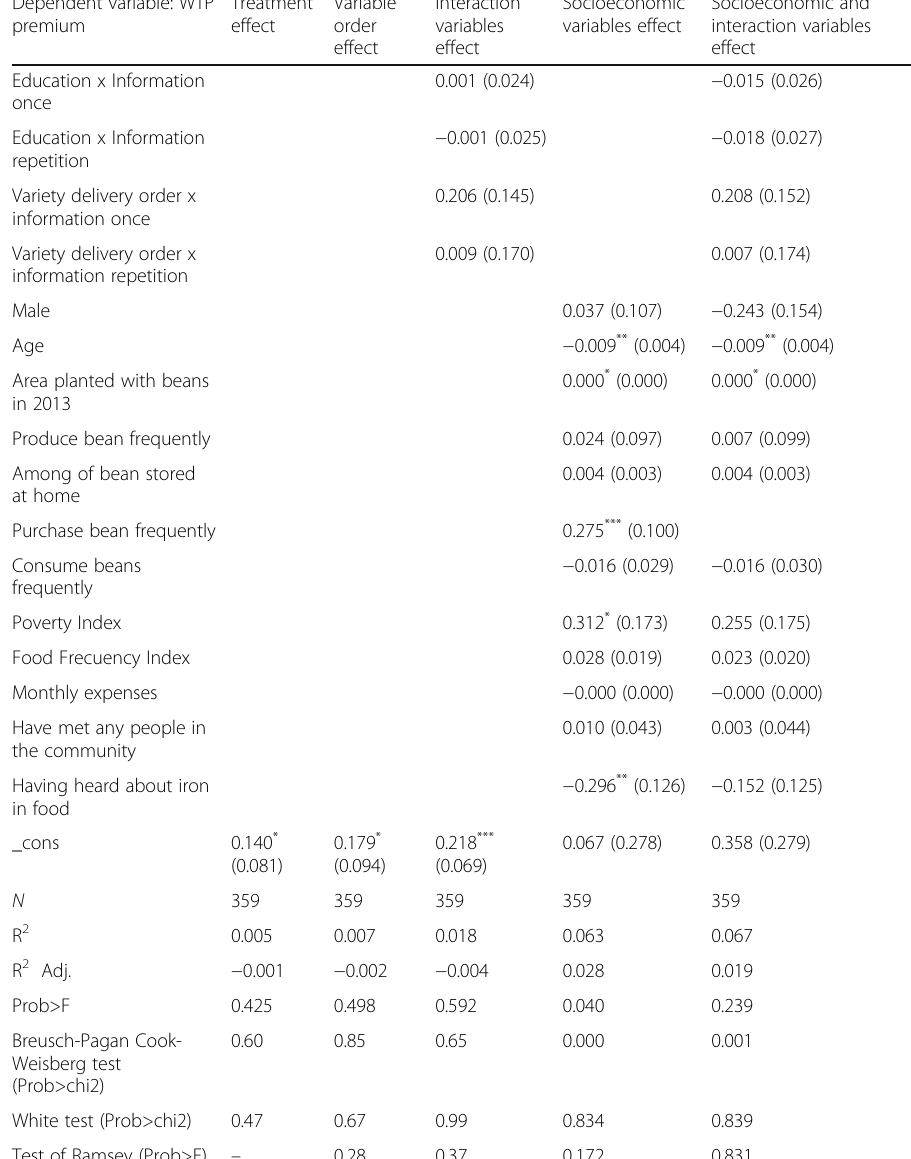
Table 6 Premium (WTP) for the iron bean variety in Guatemala (Ordinary least square model (OLS) results)